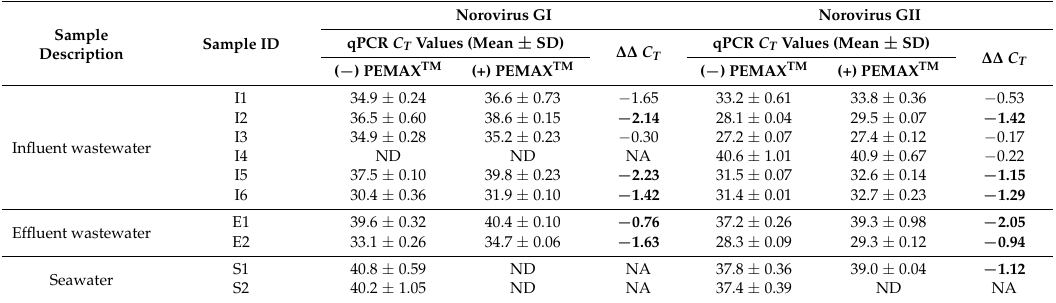
Table 2. Difference in qPCR C T values (mean and standard deviation) for norovirus GI and GII in wastewater and seawater samples with and without PEMAX TM treatment.